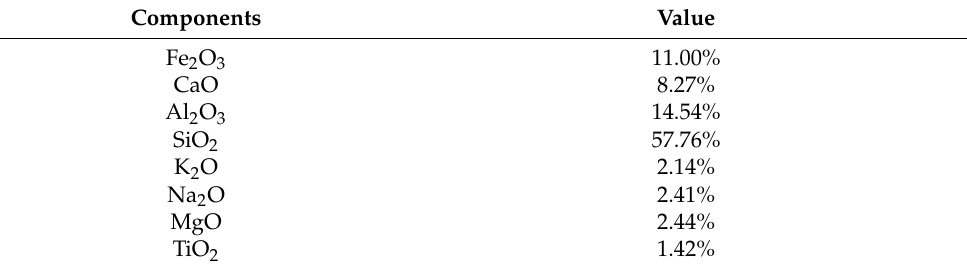
Table 1. Chemical components of volcanic